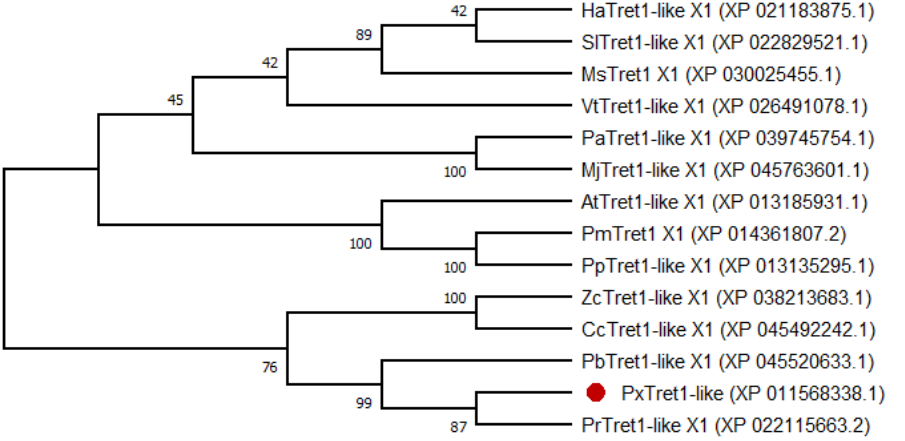
Figure 2. Phylogenetic tree of PxTret1-like from different insects based on amino acid sequences. PxTret1-like is marked by a red dot. Helicoverpa armigera : HaTret1-like X1; Spodoptera litura : SlTret1-like X1; Manduca sexta : MsTret1 X1; Vanessa tameamea : VtTret1-like X1; Pararge aegeria : PaTret1-like X1; Maniola jurtina : MjTret1-like X1; Amyelois transitella : AtTret1-like X1; Papilio machaon : PmTret1 X1; Papilio polytes : PpTret1-like X1; Zerene cesonia : ZcTret1-like X1; Colias croceus : CcTret1-like X1; Pieris brassicae : PbTret1-like X1; Plutella xylostella : PxTret1-like ; Pieris rapae : PrTret1-like X1 .